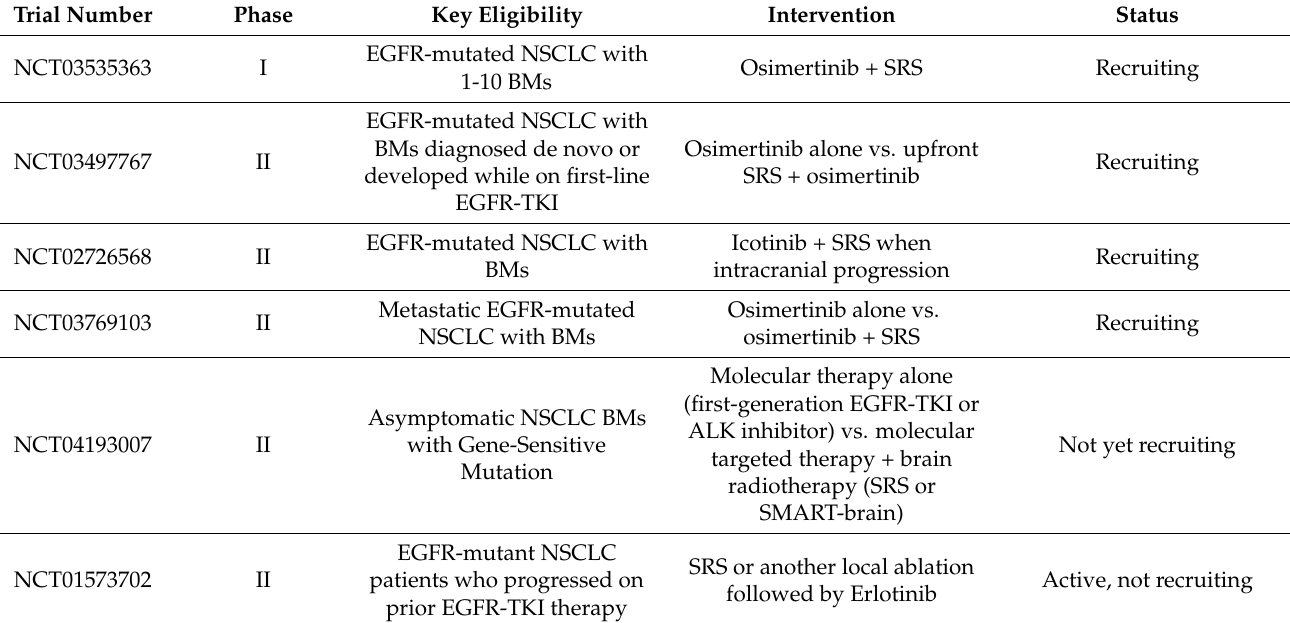
Table 1. Ongoing combination trials with SRS and EGFR-TKI in EGFR+ NSCLC